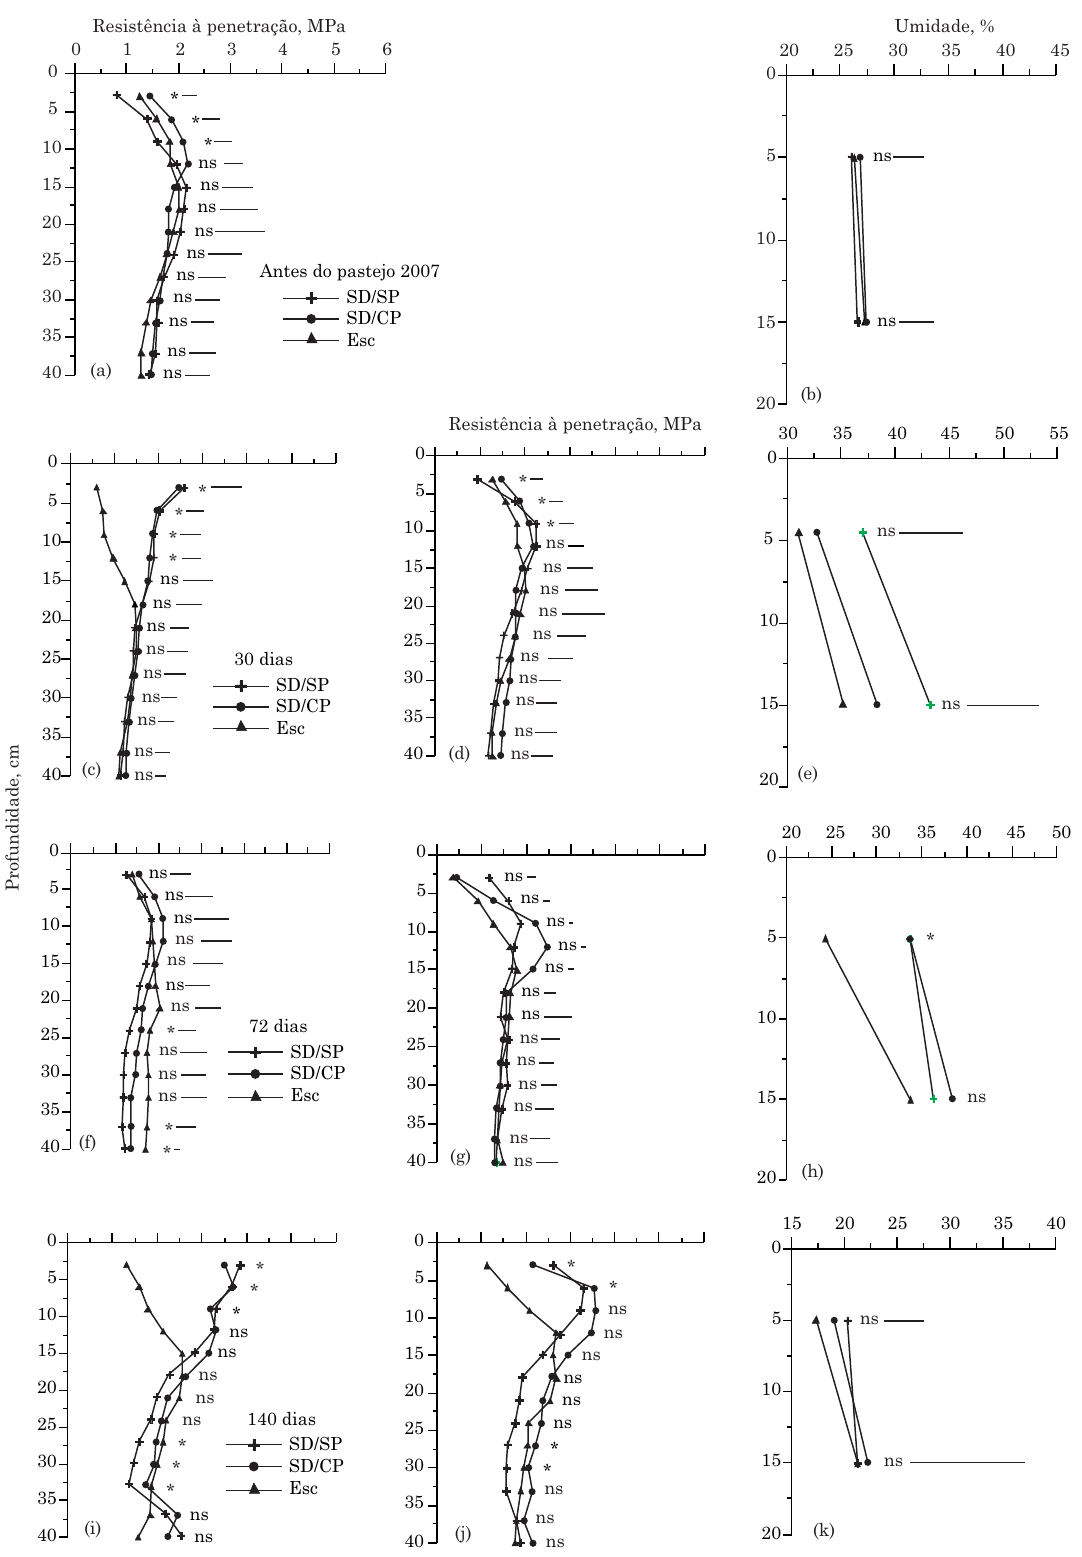
Figura 1. Variação da resistência do solo à penetração na linha e entrelinha e da umidade com a profundidade antes do pastejo (a, b), 30 dias (c, d, e), 72 dias (f, g, h) e 140 dias (i, j, k), após a semeadura da soja no manejo escarificado (ESC), semeadura direta sem pisoteio animal (SD/SP) e semeadura direta com pisoteio animal